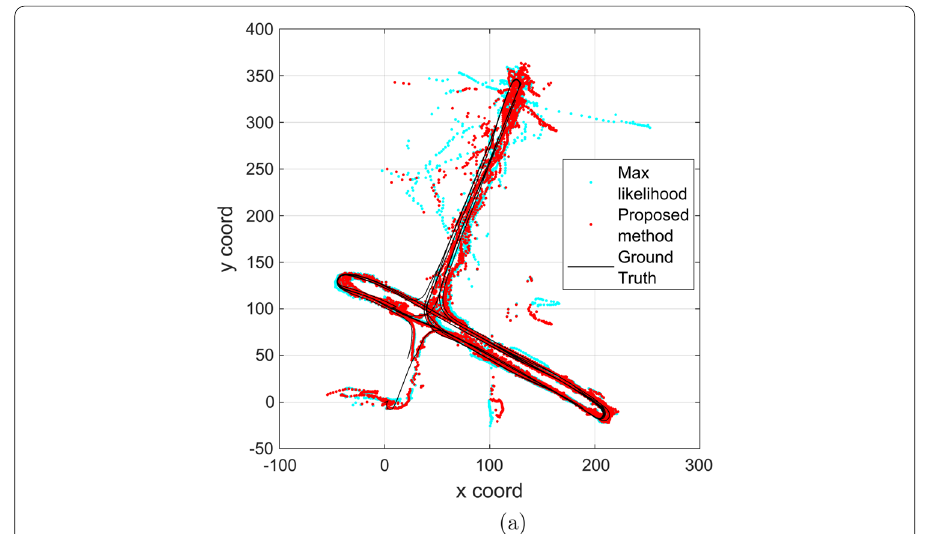
Fig. 10 GPS-based localization results with robust M-estimation and using the proposed variance estimator and the ML variance estimator